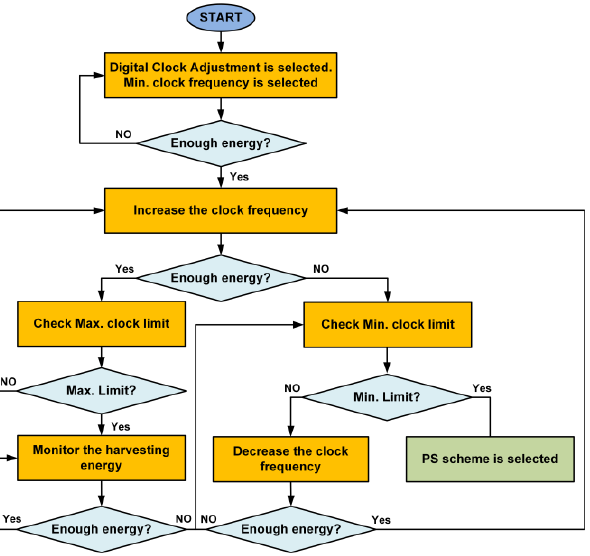
Figure 9. Flow diagram for the SWIPT transmitter during the digital clock adjustment.